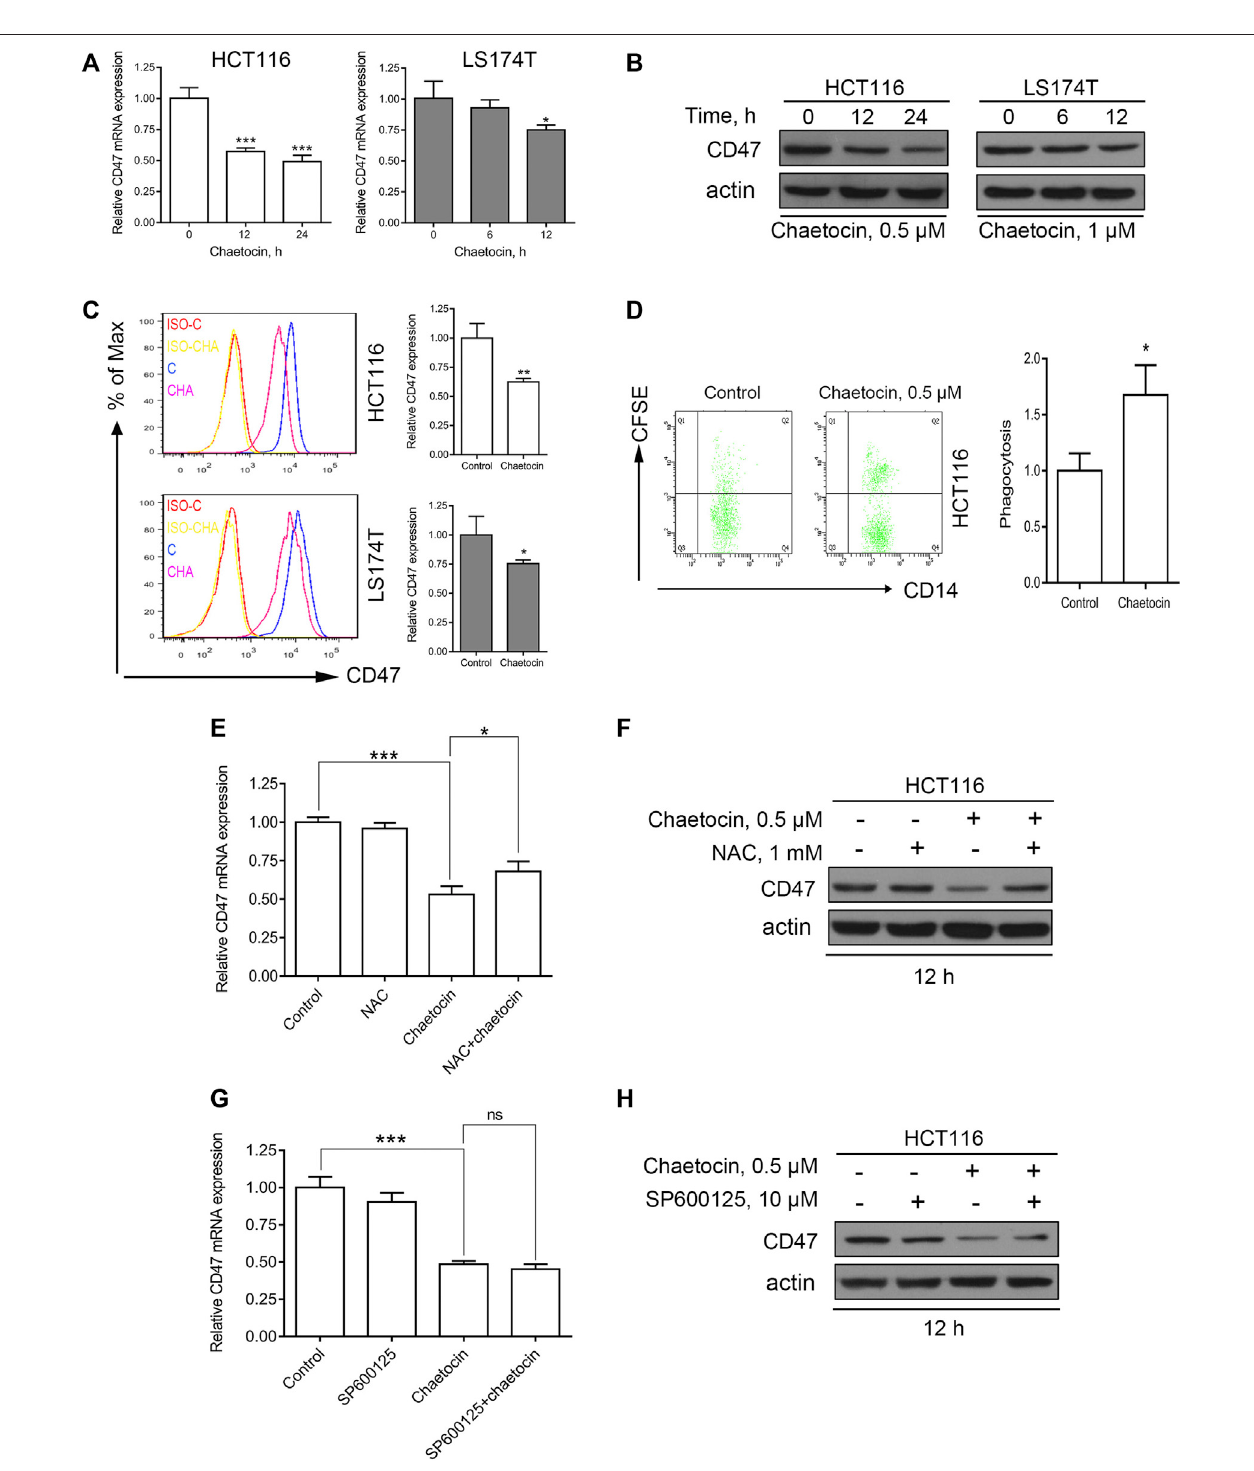
FIGURE 7 | Chaetocin decreases the expression of CD47 in CRC cells and enhances the phagocytosis of macrophages. (A) The expression of CD47 at mRNA levels was detected by qPCR after HCT116 and LS174T cells treated with chaetocin (0.5 μ M chaetocin for HCT116 cells and 1 μ M chaetocin for LS174T cells) for the indicated times. * p < 0.05, *** p < 0.001. (B) The expression of total CD47 protein was analyzed by western blot after chaetocin treatment. (C) The expression of membrane CD47 protein was detected by fl ow cytometry after HCT116 and LS174T were treated as described (* p < 0.05, ** p < 0.01). (D) HCT116 cells were pretreated with 0.5 μ M chaetocin for 24 h and then co-cultured with macrophages for another 24 h, the phagocytosis of HCT116 cells by macrophages was detected by fl ow cytometry. * p < 0.05. HCT116 cells were pretreated with 1 mM NAC for 2 h and then co-treated with 0.5 μ M chaetocin for another 12 h (E) The mRNA level of CD47 was detected by qPCR. * p < 0.05, *** p < 0.001. (F) The expression of total CD47 protein was detected by western blot. SP600125 rescue analysis was done as previously mentioned. (G) mRNA expression of CD47 detection by qPCR (*** p < 0.001). (H) The amount of CD47 protein expressed was evaluated by western blot.